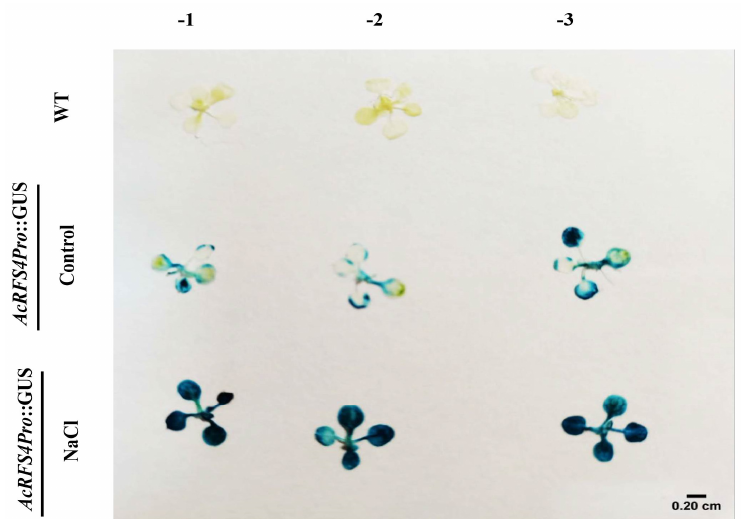
Figure 8. AcRFS4Pro ::GUS transgenic Arabidopsis of 10-day-old seedlings grown in MS/2 media without (Control) and with 150 mM NaCl for 24 h. Markers -1, -2 and -3 indicate three independent lines of wild type (WT) and transgenic plants ( AcRFS4 Pro::GUS). Scale bars = 0.2 cm.